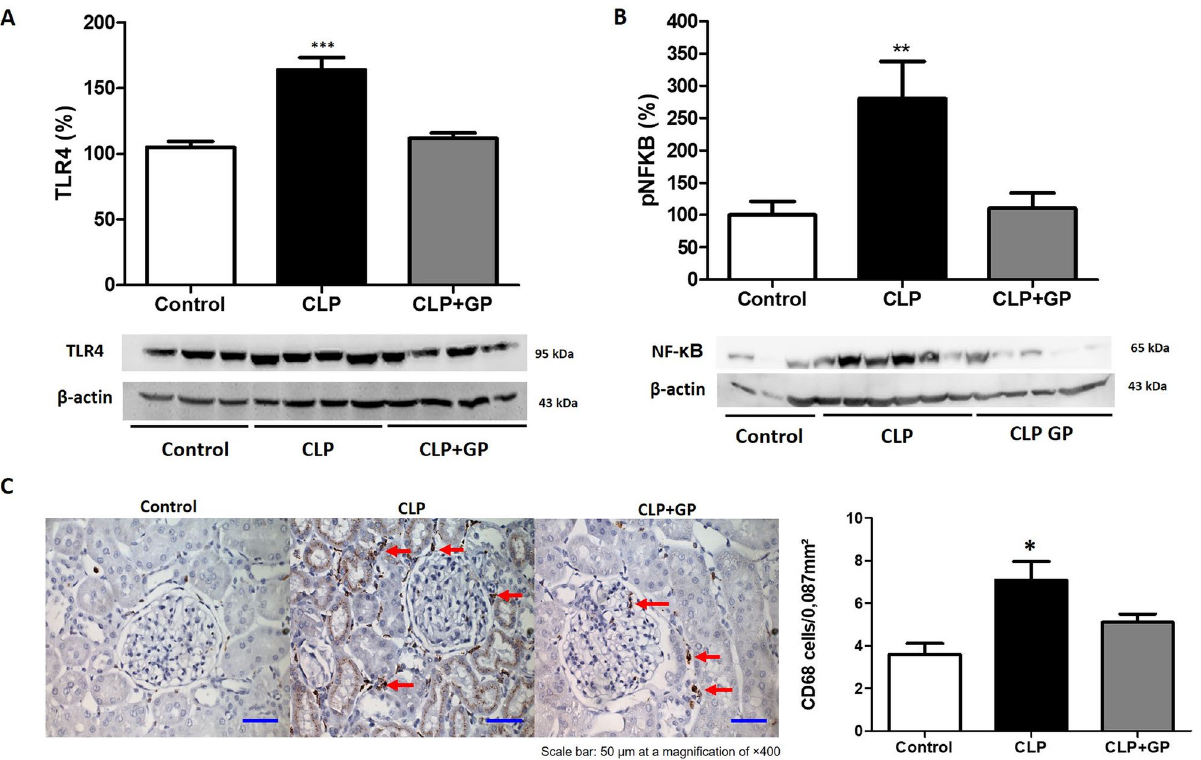
Figure 5. Toll-like receptor 4/nuclear factor-kappa B (TLR4/NF-κB) signaling pathway in renal tissue in control, cecal ligation and puncture (CLP), and CLP + green propolis (CLP + GP) group rats 24 h after the CLP or sham procedure. ( A ) Immunoblotting of TLR4 protein expression in renal tissue; ( B ) Immunoblotting of NF-κB protein expression in renal tissues; ( C ) Macrophage infiltration in renal tissues analyzed by immunohistochemistry. We analyzed 30 grid fields (0.087 mm 2 each) per kidney cortex, counting the number of infiltrating CD68 + cells in each field, on the basis of which we calculated the mean numbers in the renal cortical tubulointerstitium and the mean counts per kidney. * p < 0.05 versus control and CLP + GP; *** p < 0.001 versus control and CLP + GP; ** p < 0.01 versus control and CLP + GP. Groups Parameter